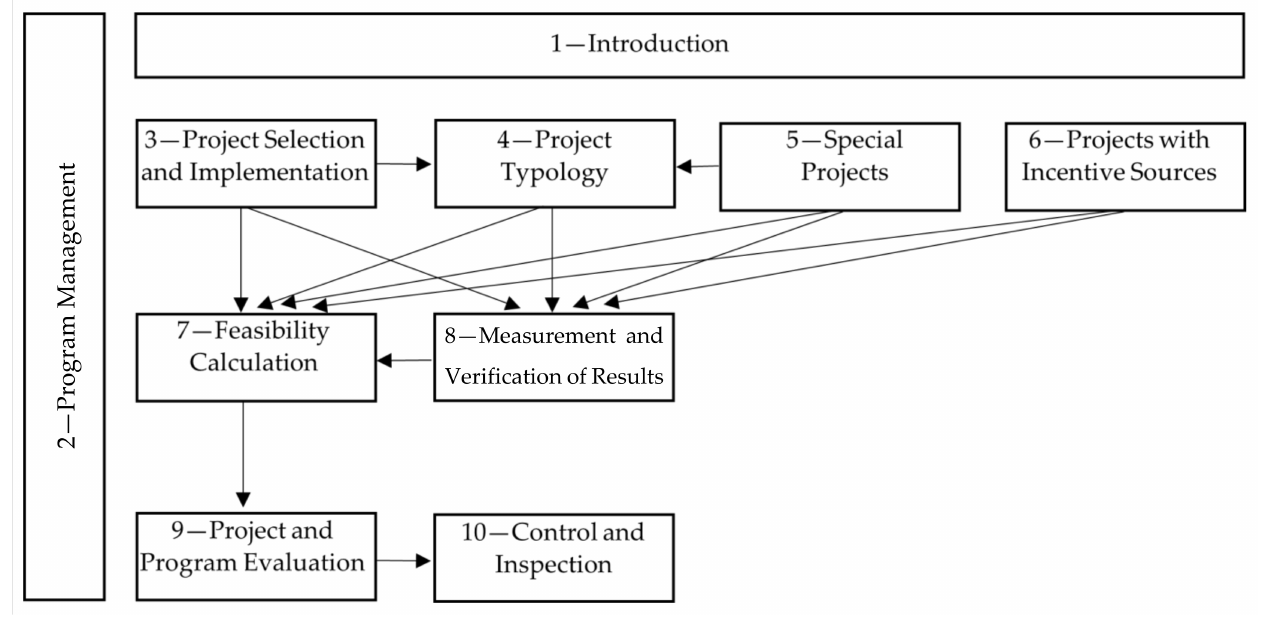
Figure 1. PROPEE (Procedures of the Energy Efficiency Program)